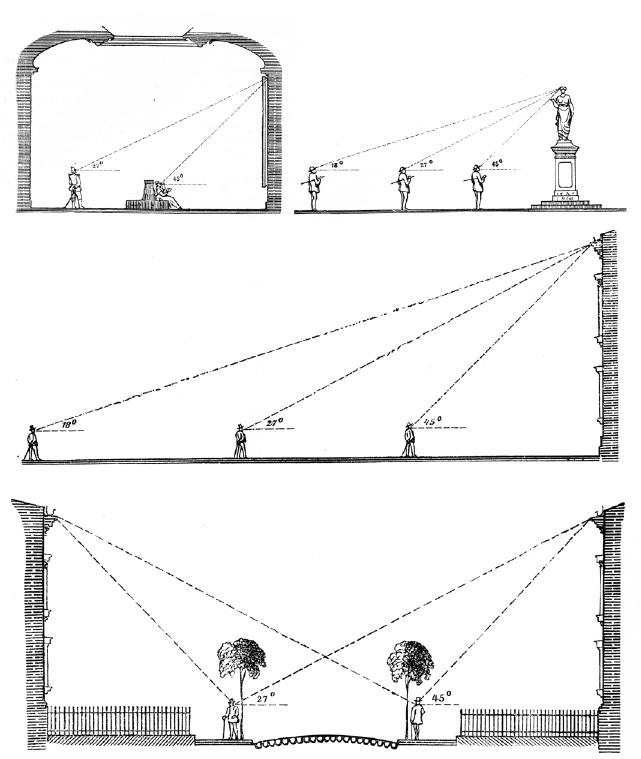
Fig. 2 Hermann Maertens, Der Optische-Maassstab, Maertens’ diagram of triad of angles. The 18, 27, and 45 degrees visual angles in the contemplation of pictures in a gallery, of a monument in a garden, of the facade of a building, and in designing a street section (Maertens,